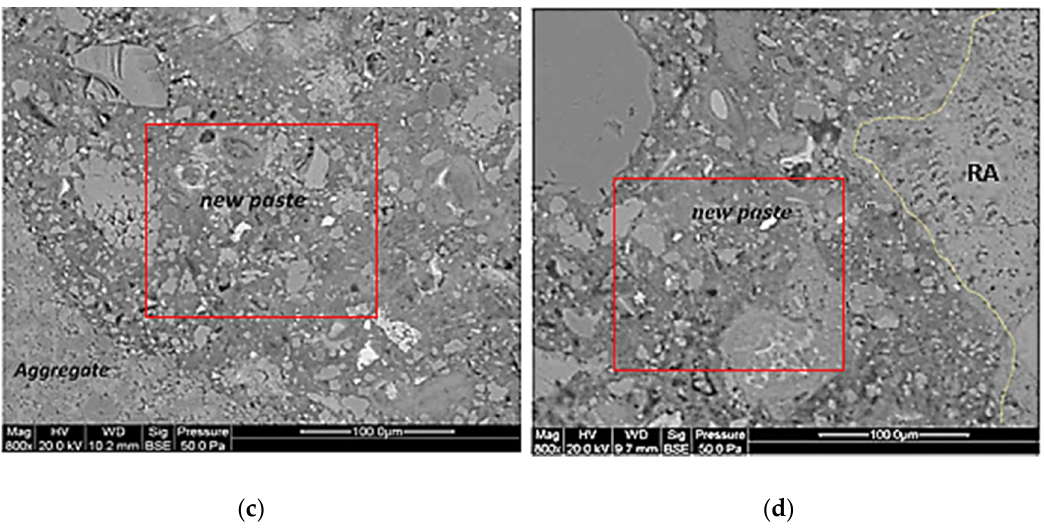
Figure 8. SEM images of new pastes ( a ) NP0, ( b ) NP30, ( c ) NP50 and ( d ) NP100